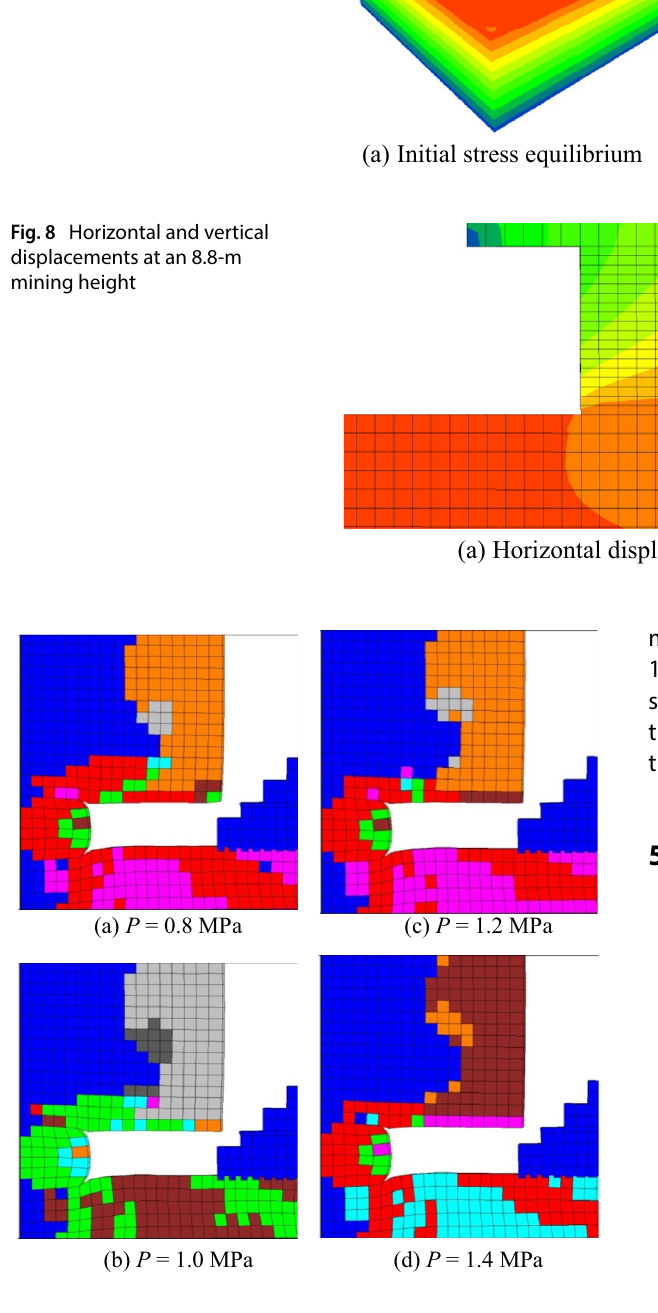
Fig. 9 Support pressure at coal